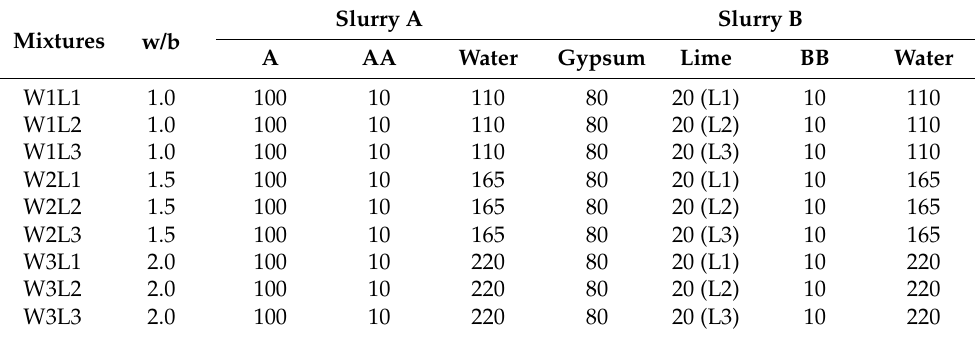
Table 2. The mixture proportions of the high water grouting materials.